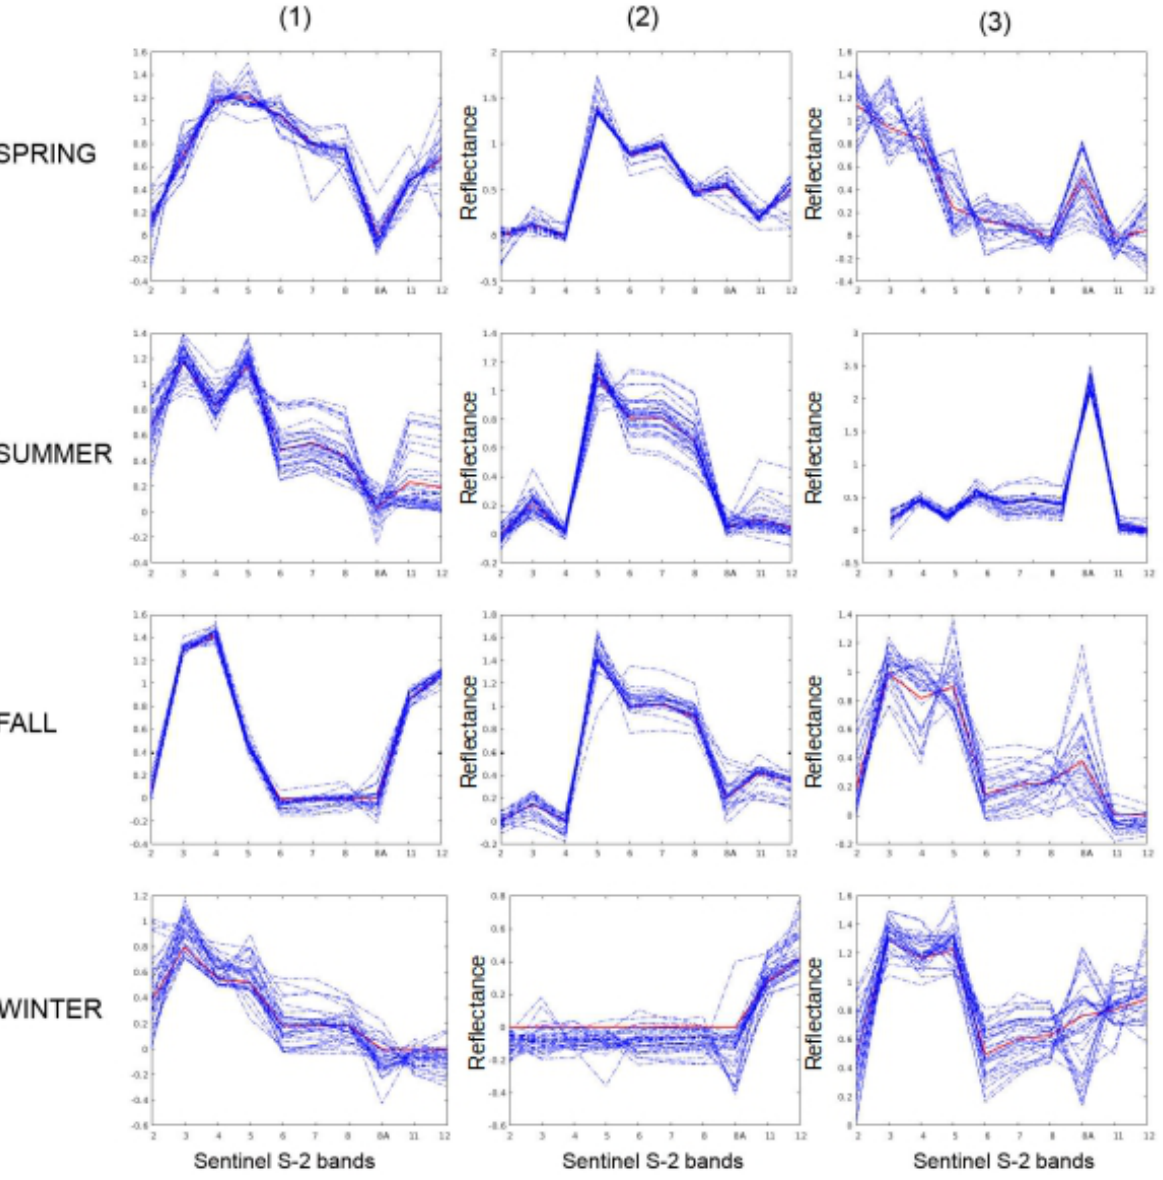
Figure 2. Multi-temporal Endmembers calculated for each season; in thick red line the seasonal endmember and in dashed blue line its perturbance (dMt) vectors